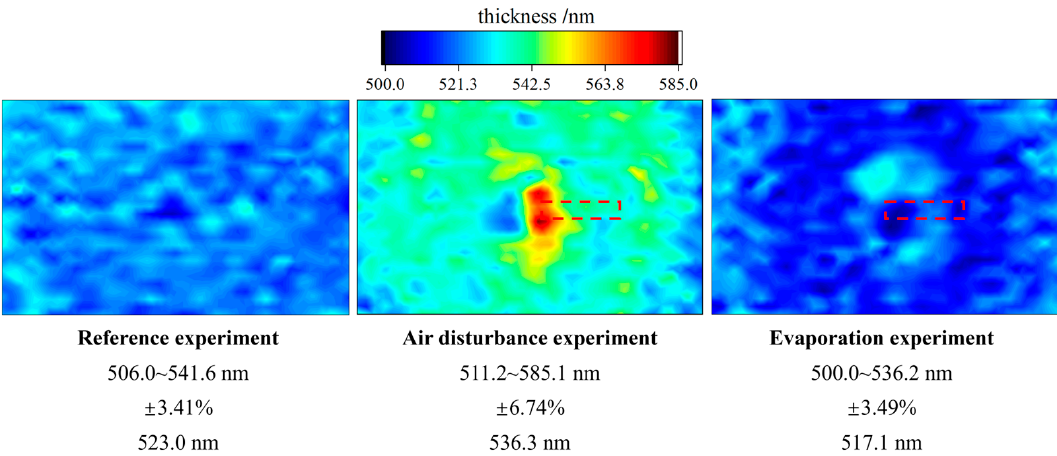
Figure 7. Comparison of the results of the reference group and experimental group. The relative position of the disturbance plate is marked in the distribution chart of the airflow disturbance group and evaporation group, respectively.